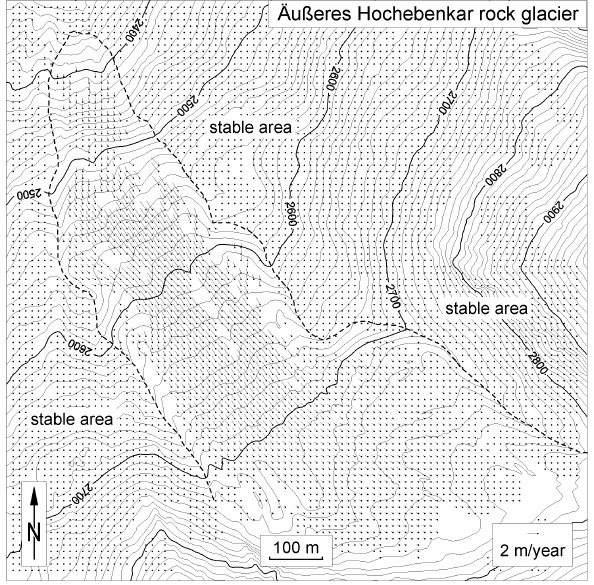
Figure 7. Mean annual horizontal displacement vectors at Äußeres Hochebenkar rock glacier for the time period 1997- 2003 derived from orthophotos. Image data 1997: BEV, 100 cm GSD, image data 2003: Microsoft Bing Maps, 100 (160) cm GSD, grid spacing: 12 × 12 pixel, template size for image matching: 25 × 25 pixel, 6044 valid points, precision of measurements: ±9.2 cm/year (1 sigma), maximum velocity: 2.12 m/year.